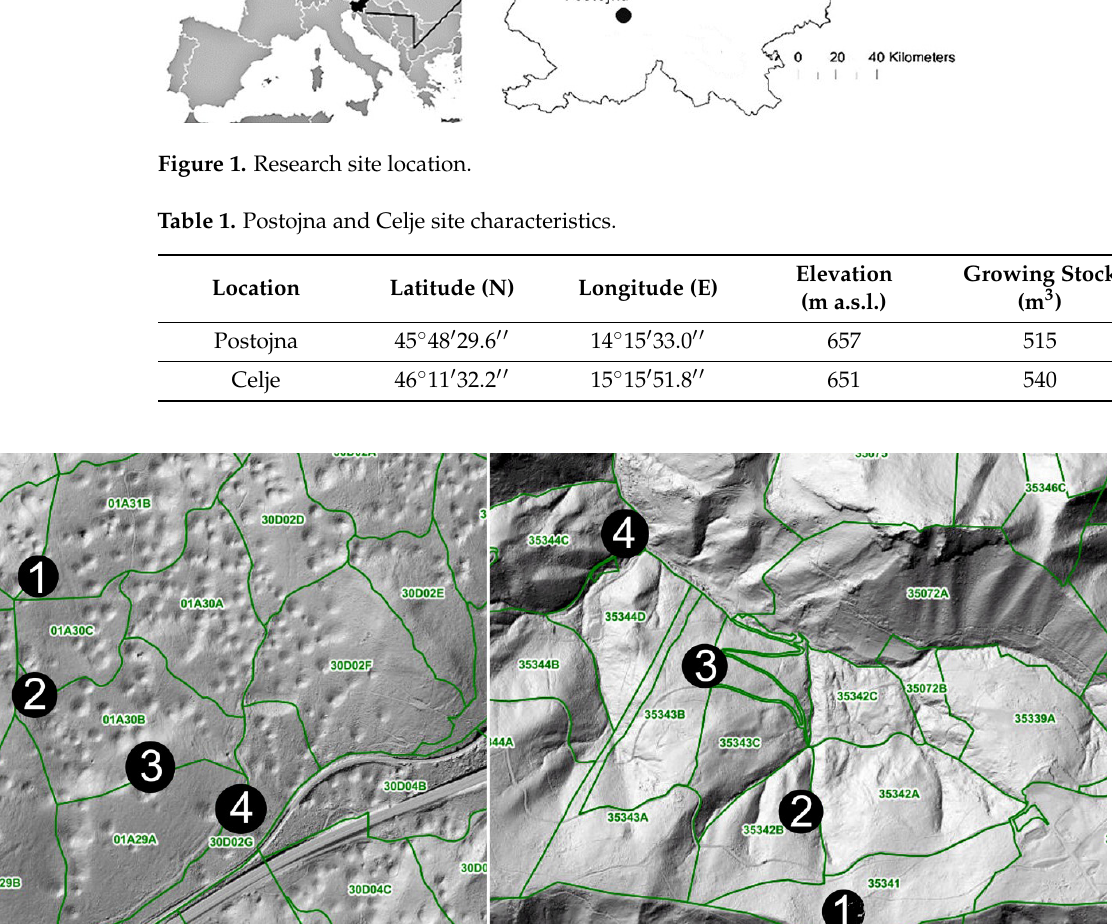
Figure 1. Research site location. Table 1. Postojna and Celje site characteristics.